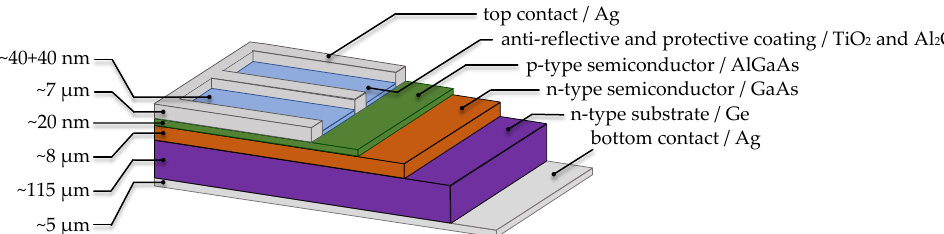
Figure 13. Simplified model structure of the single-junction GaAs solar cell. Essential layers are GaAs/AlGaAs, which create a pn junction, where AlGaAs is only thin layer of 20 nm. An important function of protection and anti-reflection against the adverse effects performs Al 2 O 3 and TiO 2